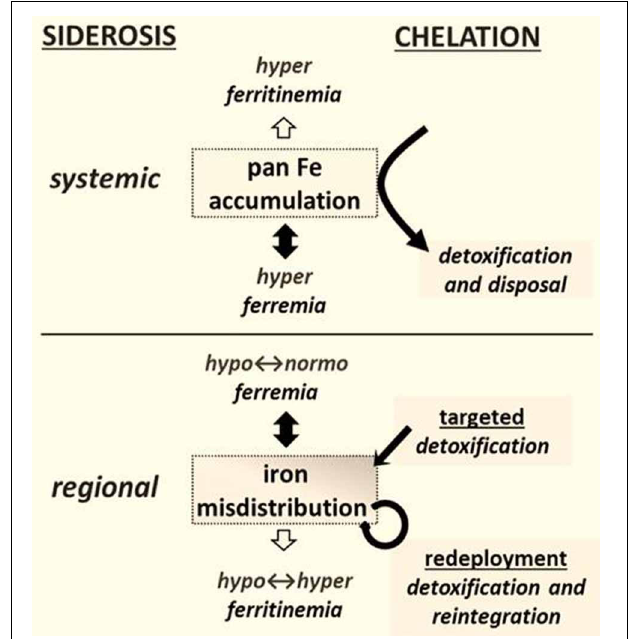
FIGURE 1 | Chelation modalities as treatments for siderosis. Systemic siderosis (e.g., hemosiderosis) is characterized by elevated plasma iron levels (hyperferremia) that leads to organ iron accumulation and is generally characterized by elevated plasma ferritin (i.e., hyperferritinemia) that other than in a context of inflammation reflects iron stores. Chelation is designed to detoxify organs from surplus iron and dispose the latter via biliary or urinary secretion. Regional siderosis covers a wide spectrum of inherited disorders (e.g., Friedreich ataxia, sideroblastic anemias, iron-refractory-iron-deficiency anemia-IRIDA), and acquired disorders (e.g., anemia of chronic disease-ACD or cancer) that are characterized by a maldistribution of iron within cells of particular organs (e.g., cardiomyocytes or neurons or blast cells) or at the level of the organism (e.g., liver and spleen versus plasma). The plasma iron levels can span from subnormal (as in functional iron deficient anemias) to supranormal (as in sideroblastic anemias) and likewise those of plasma (or serum) ferritin levels. Chelation is designed here not merely to detoxify a siderotic region but where applicable render the chelated iron available for reuse. The new chelation modalities comprise (i) targeted detoxification, whereby a prochelator is activated at the target site by specific resident activators, as found in some brain areas (Sohn et al., 2008; Zheng et al., 2009) and (ii) iron redeployment, whereby a chelator that detoxifies cells from surplus iron and/or also scavenges essential iron reintegrates the metal into the erythron or specific tissues (Breuer and Cabantchik, 2009; Sohn et al.,